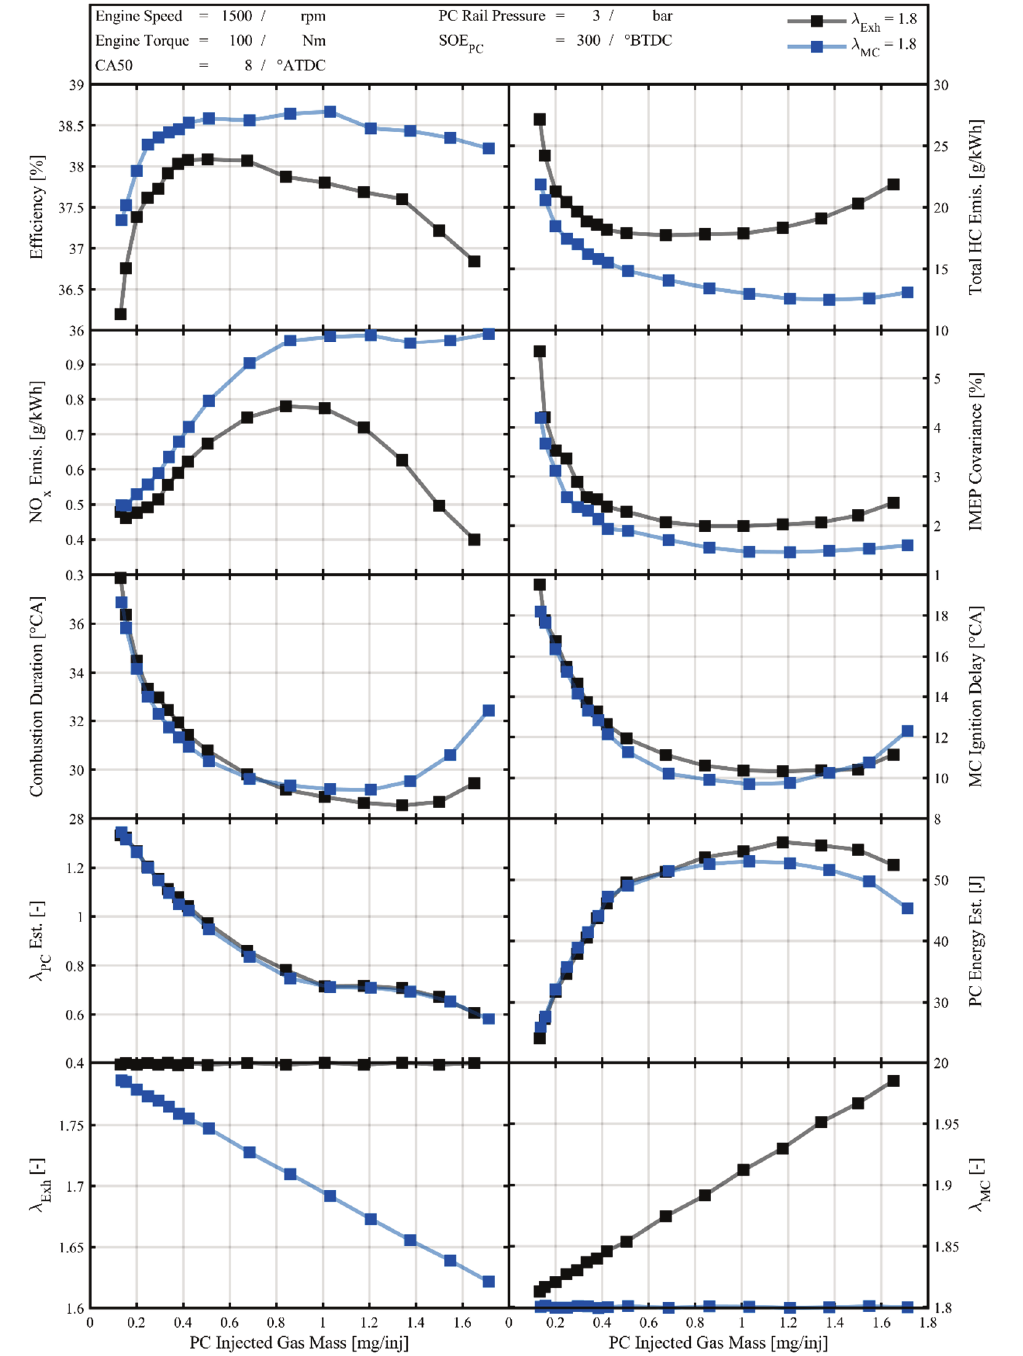
Fig. 9. Variation of the CNG mass injected into the pre-chambers. For the first (black) measurement series, the exhaust gas air-to-fuel ratio was controlled to λ Exh = 1.8 and for the second (blue) measurement series, the main-chamber air-to-fuel ratio was controlled to λ MC =